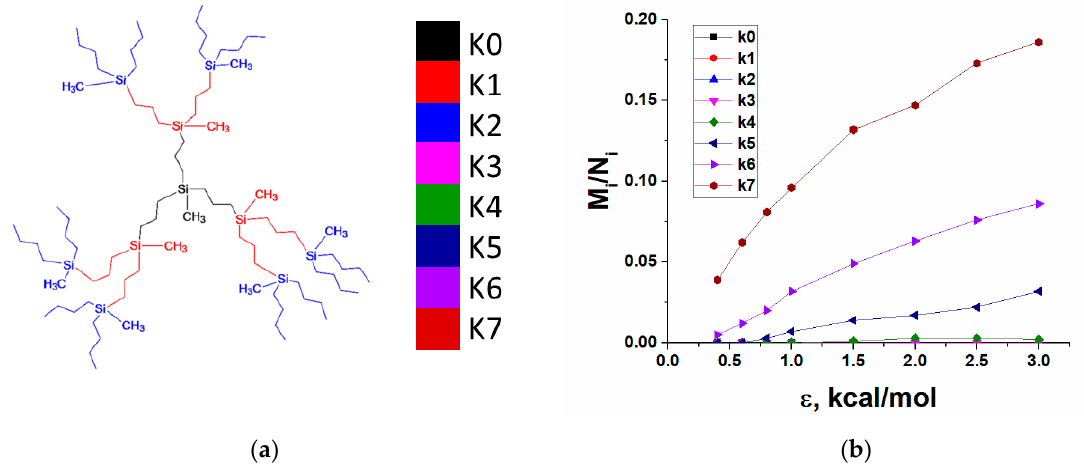
Figure 4. ( a ) Schematic representation of the classification of structural layers. Different colors show different layers numbered from the dendrimer core, Ki corresponds to the layer number. ( b ) Dependence of the number of contacts in each structural layer on the adsorption energy parameter ε calculated for the seventh generation of the C4 dendrimer.